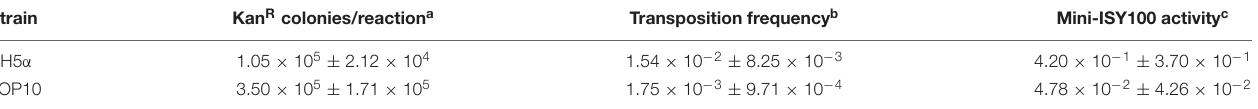
a Number of Kan R colonies obtained from a single reaction. b Number of colonies on LB/Kan divided by the number of colonies on LB. c Transposition frequency divided by frequency of conjugation using E. coli π 3 as recipient (3.66 × 10 − 2 ± 2.55 × 10 − 2 ).